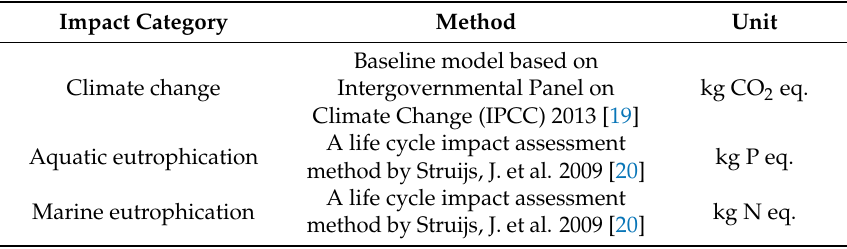
Table 5. Impact categories for environmental